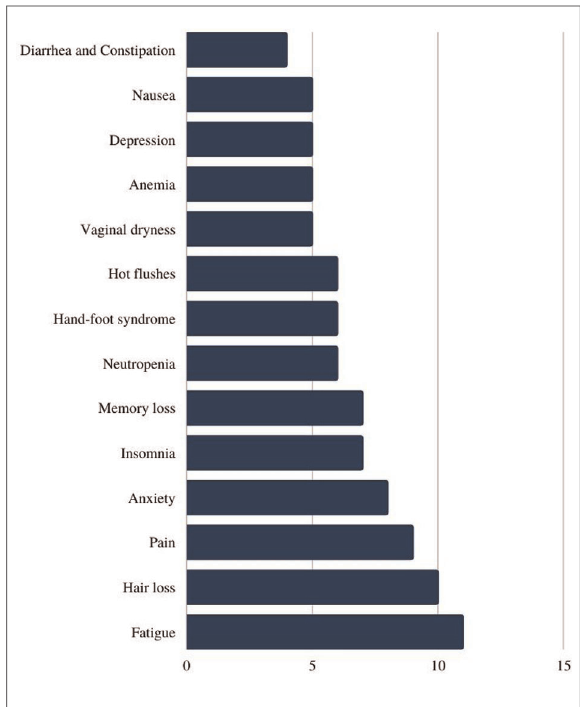
FIGURE 1 Most reported side effects related to breast cancer treatment (absolute